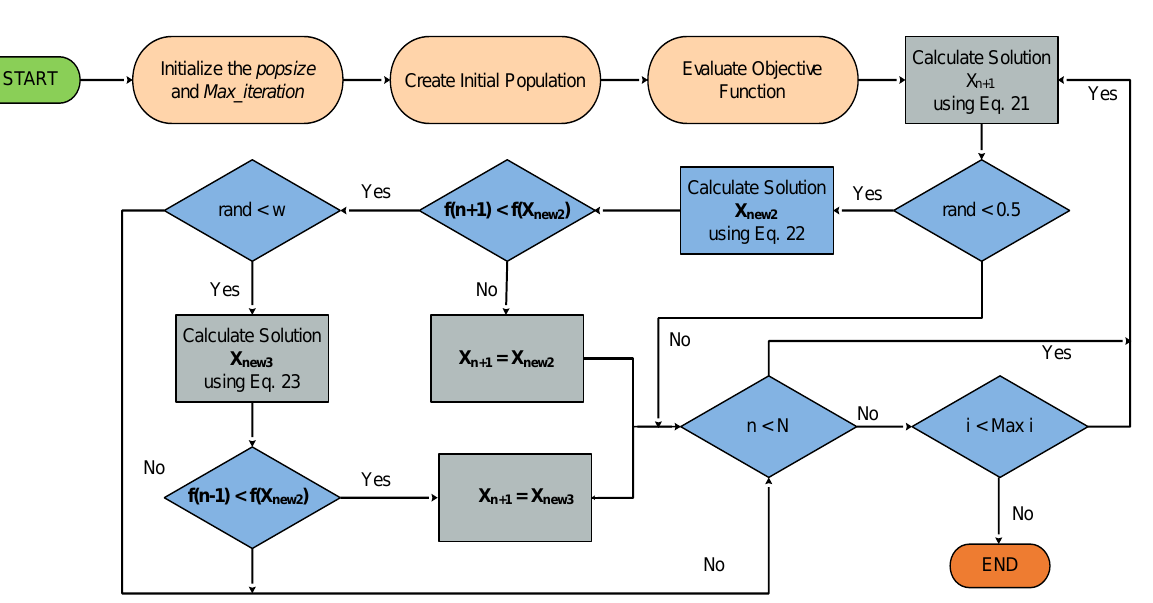
Figure 6. Workflow for the RUN algorithm.